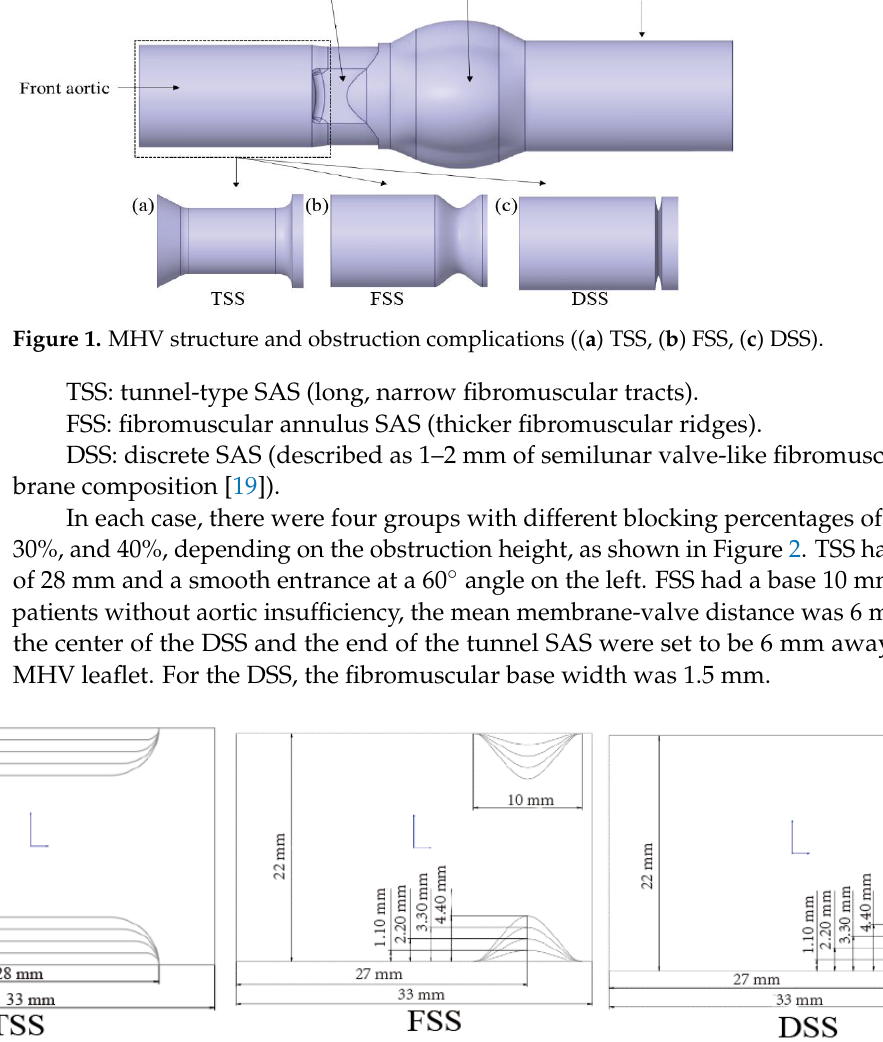
Figure 2. Model geometry with dimensions for three types of SAS (obstruction height: 1.1, 2.2, 3.3, and 4.4 mm).